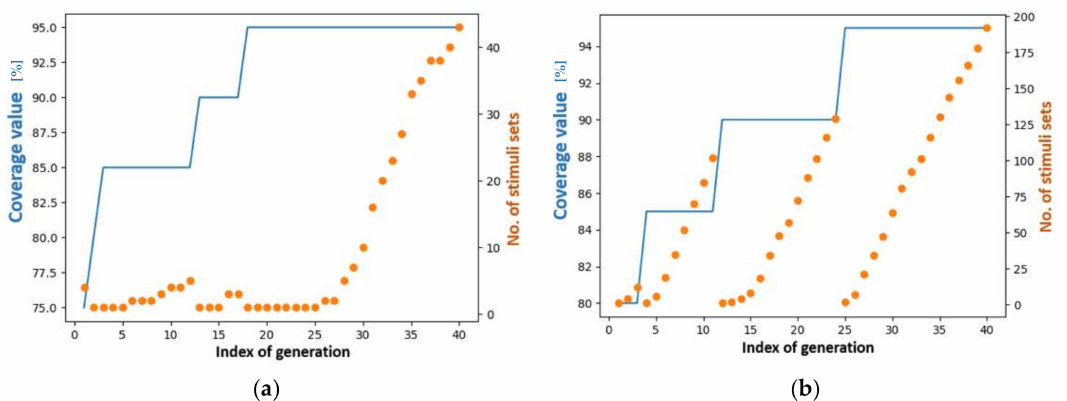
Figure 8. Two examples for evolution of a population of 20 individuals across 40 generations during the v3.3 approach: ( a ) represents the visual description of the numerical data inTable 6; ( b ) represents the visual description of another result of the same v3.3 approach.